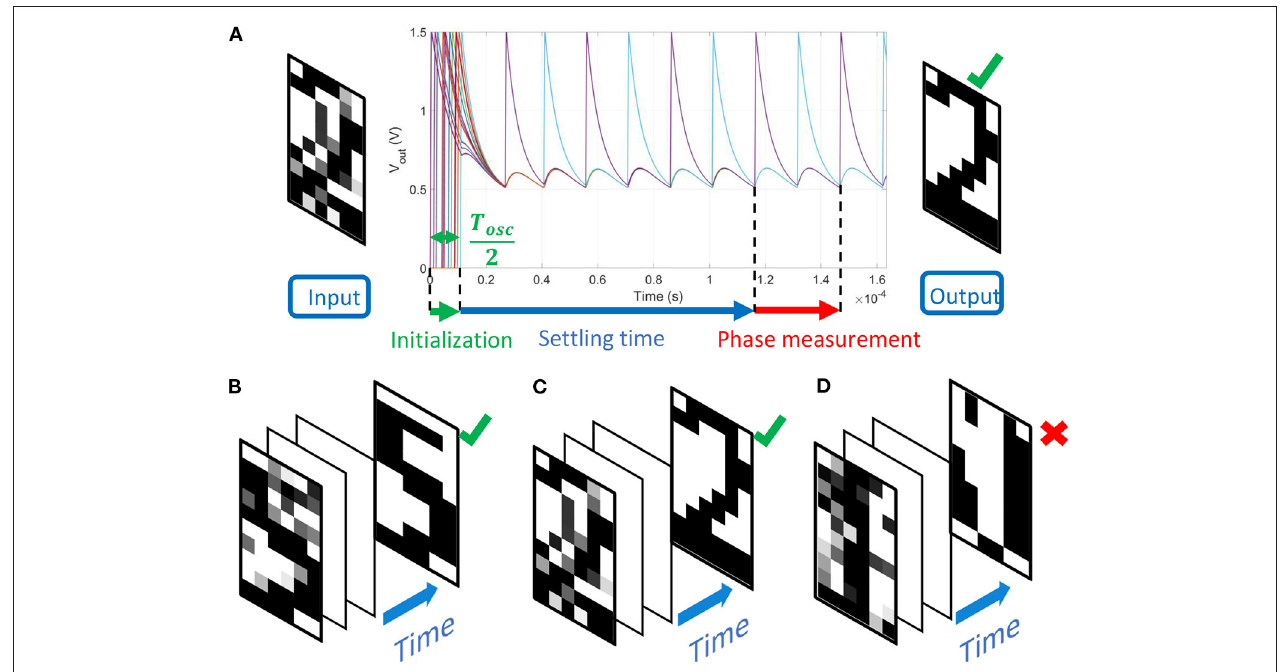
FIGURE 13 | (A) Noisy input image “2” with 15 random altered pixels and voltage waveforms of 60 oscillators. ONN is initialized during T osc / 2 with the noisy input image. After few oscillation cycles, ONN settles, and phases are measured. ONN retrieves the correct output image that corresponds to the stored pattern “2.” (B) The input image “5” has been altered at 15 random pixel locations by a uniform distribution. ONN retrieves the corresponding stored pattern. (C) Similarly, 15 random pixels of the input image “2” are altered, and ONN retrieves the correct corresponding pattern. (D) In this example, 20 noisy input pixels are introduced to digit “1,” and ONN converges toward a spurious